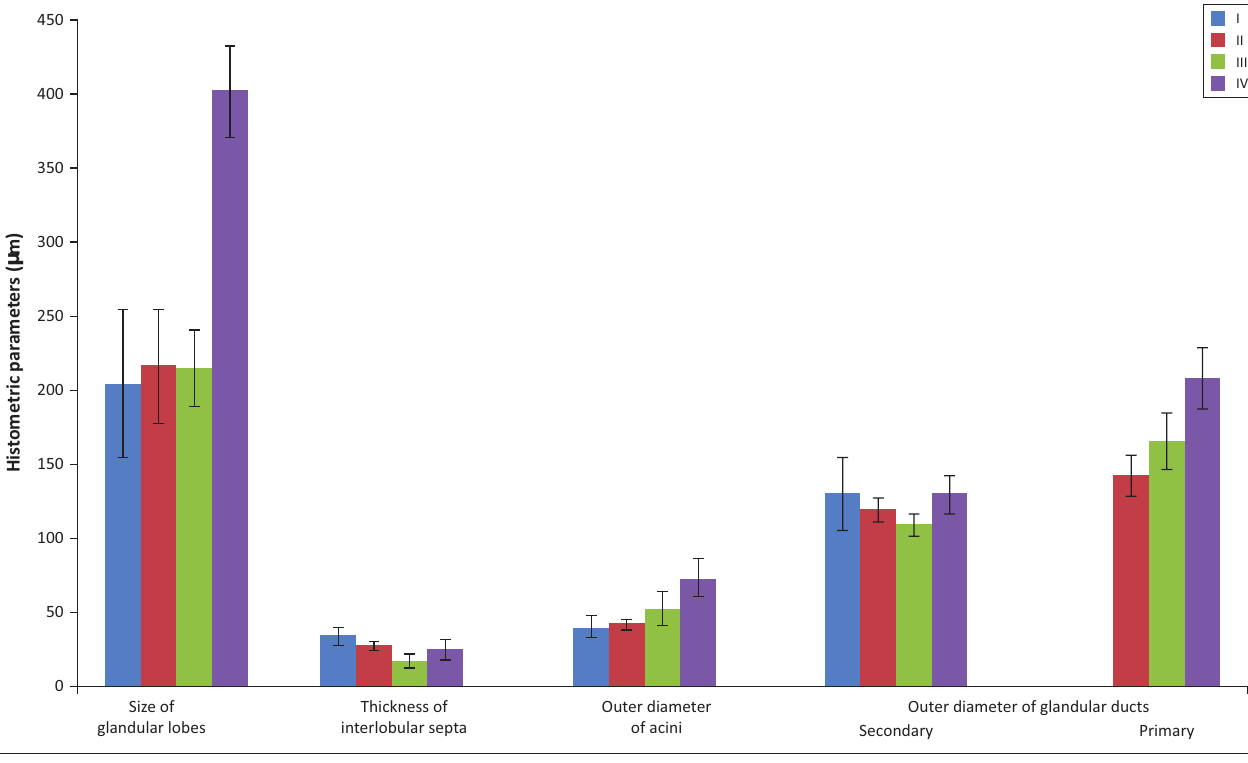
FIGURE 2: Histometric parameters of the lacrimal gland in African black ostrich in the embryonic and postnatal